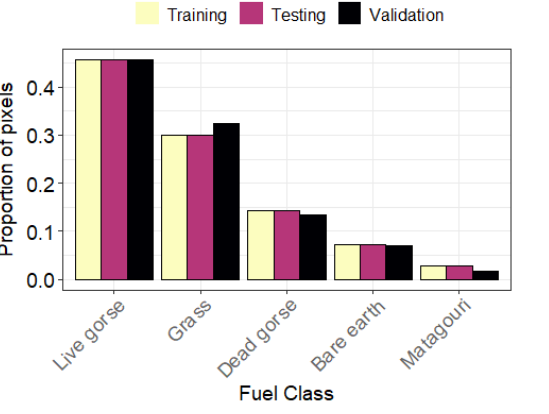
Figure 3. The relative number of pixels of each fuel class across the site in the training, testing and validation datasets.